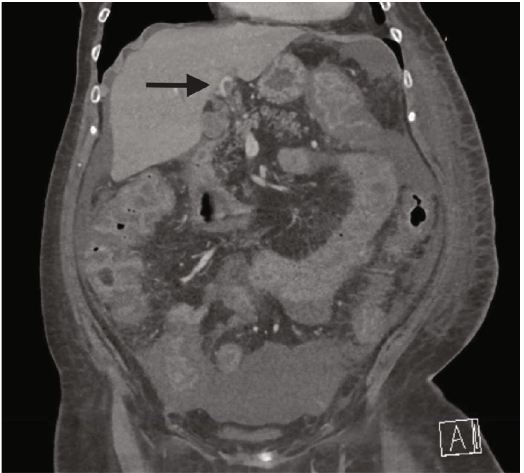
Figure 3: CT abdomen coronal view: arrow demonstrating acute left portal vein